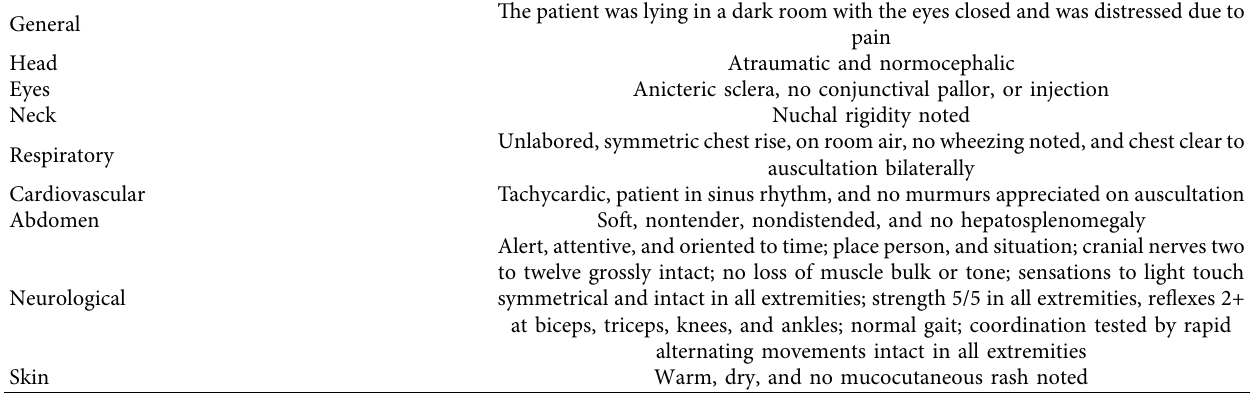
Table 1: Physical examination fndings.